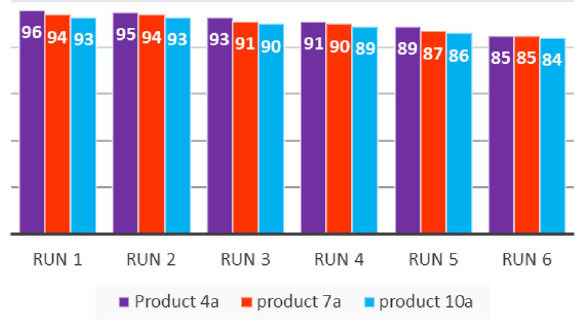
Figure 10. Reusability of nano- Gd-B 2 W 22 .